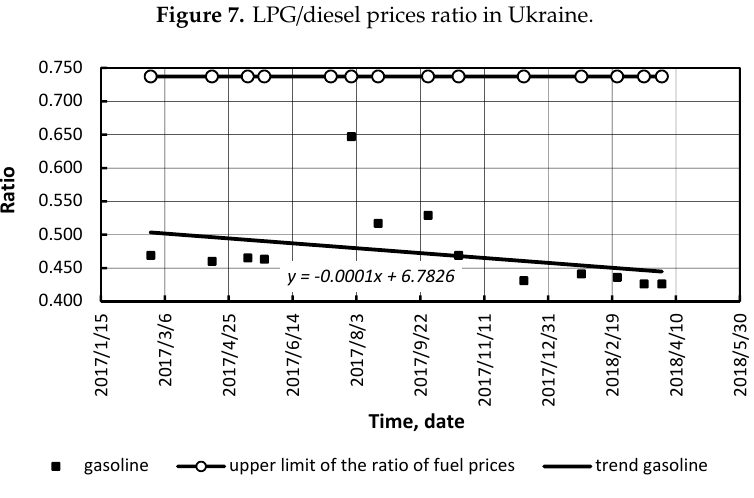
Figure 8. LPG/gasoline prices ratio in Ukraine.